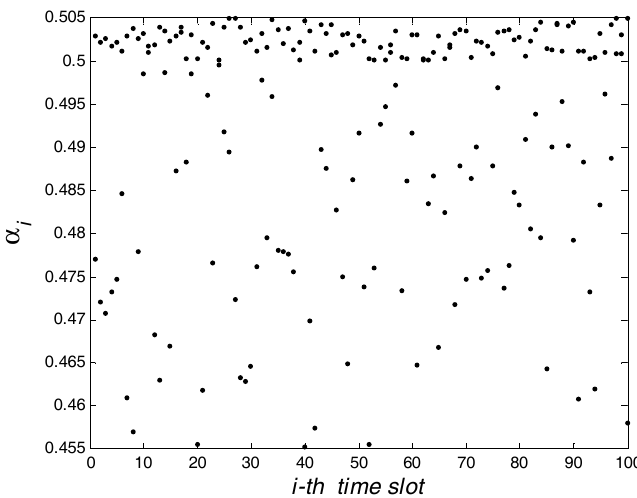
= σ 2 = 0.01 and r = 25 0 1, i 2, i